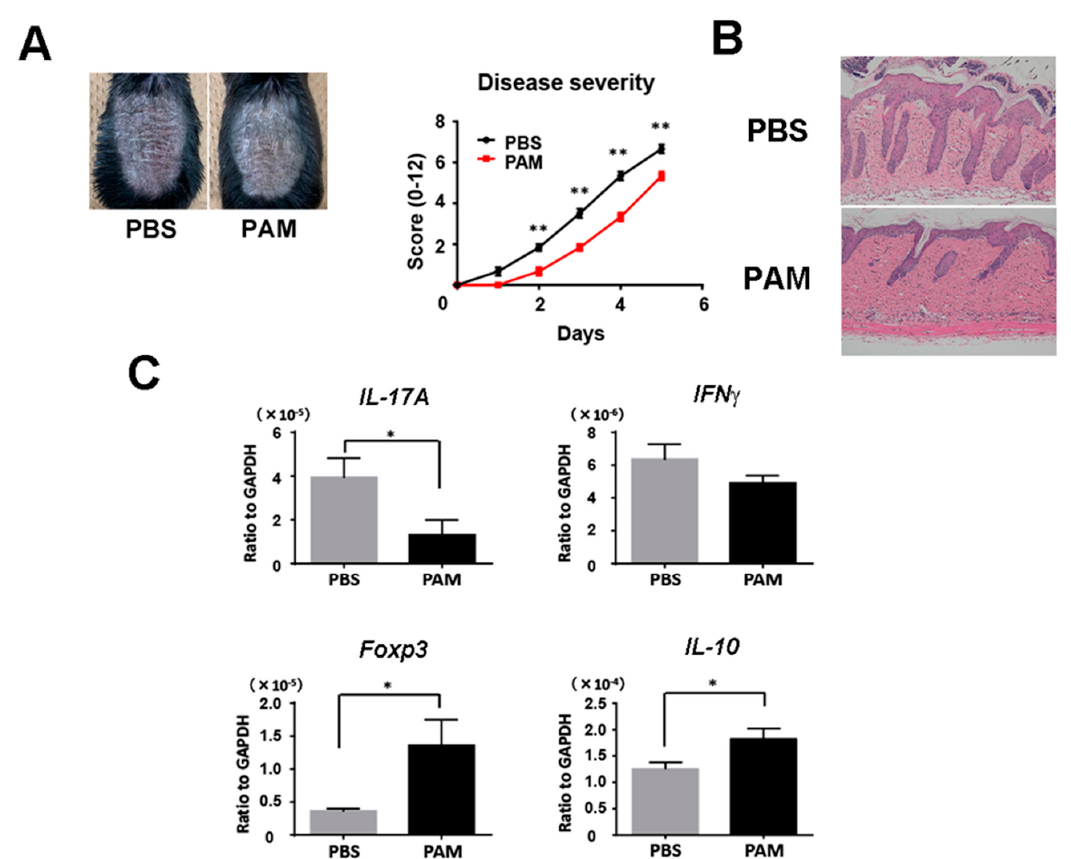
Figure 5. Systemic treatment with Pam3CSK4 and Pam2CSK4 attenuates imiquimod-induced skin inflammation. Shaved back skin of wild-type (WT) mice were topically treated with imiquimod for 5 consecutive days. Wild-type mice were injected with 50 g Pam3CSK4 and 50 g Pam2CSK4 (PAM) or PBS intravenously two days before, on the same day, and two days after imiquimod application. ( A ) The phenotypical manifestation of back skin induced by imiquimod application at day 5. ( B ) Disease severity during imiquimod treatment. Clinical scores for disease severity were calculated